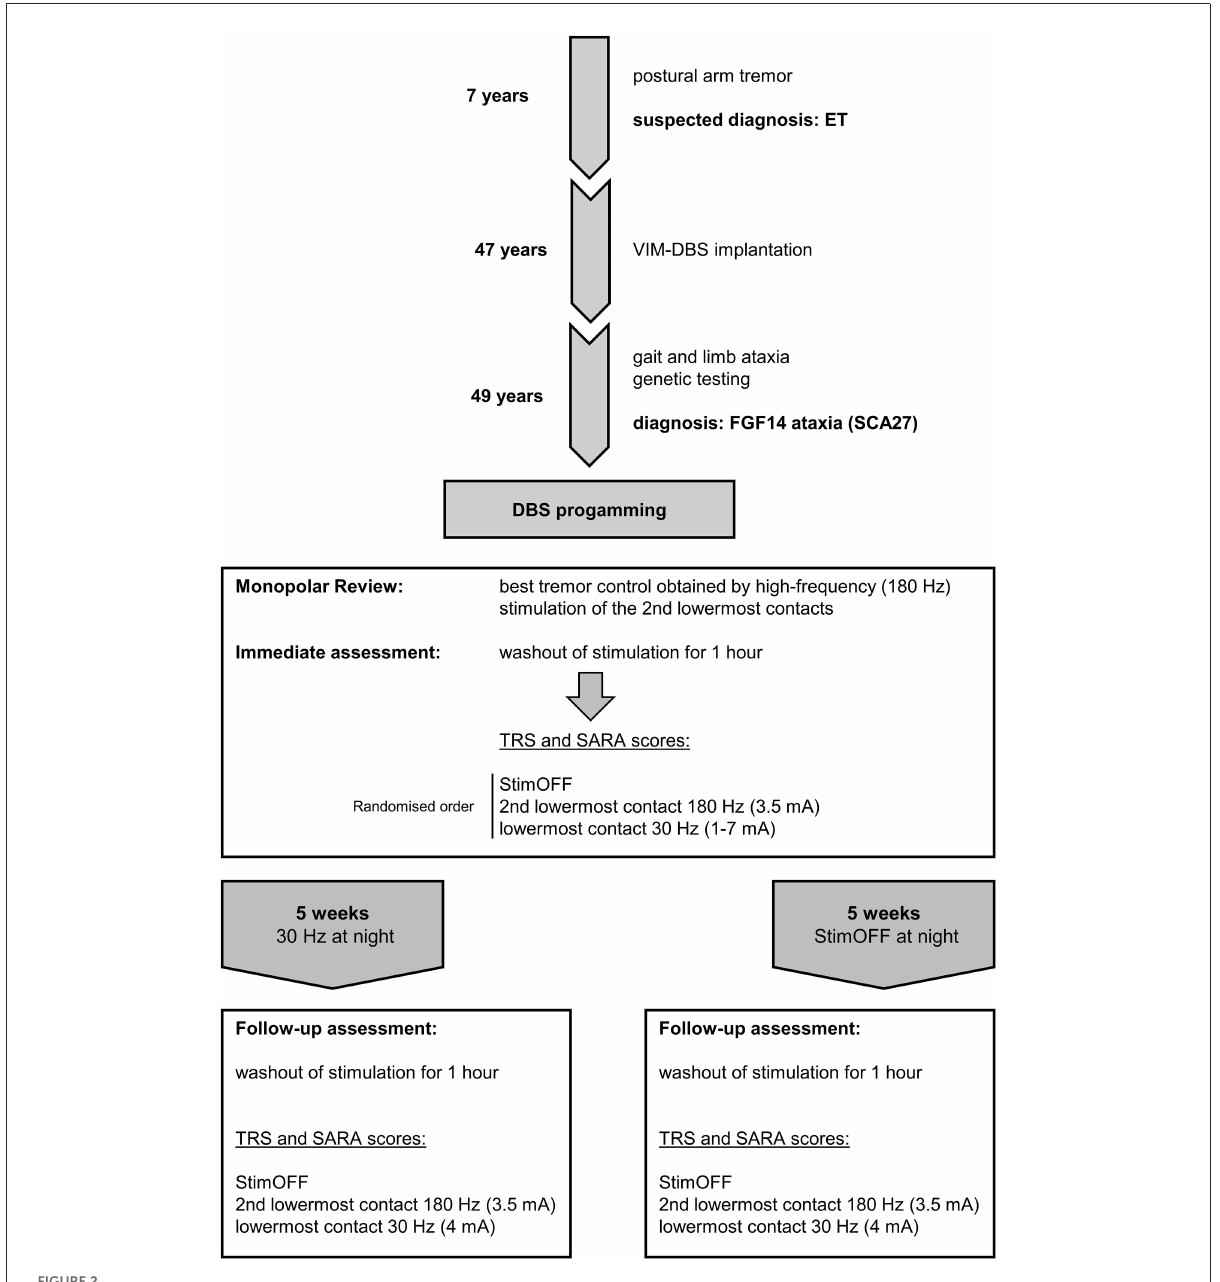
FIGURE2 Timeline of the patient’s history, diagnostic and therapeutic work-up. The patient was initially diagnosed with essential tremor (ET) due to early-onset postural arm tremor at the age of 7 years and implanted with VIM-DBS at the age of 47 years. Slowly emerging ataxia led to the diagnosis of spinocerebellar ataxia 27 (SCA 27) at the age of 49 years. Programming of deep brain stimulation (DBS) following a monopolar review showed relevant tremor attenuation by high-frequency stimulation of the 2nd lowermost contacts. The patient was randomized to follow-up stimulation settings meaning high-frequency stimulation at daytime and either StimOFF or 30Hz stimulation of subthalamic fiber tracts (lowermost contacts) at night. Both stimulation paradigms were activated for 5 weeks in a randomized order followed by clinical examinations blinded to the settings of the previous